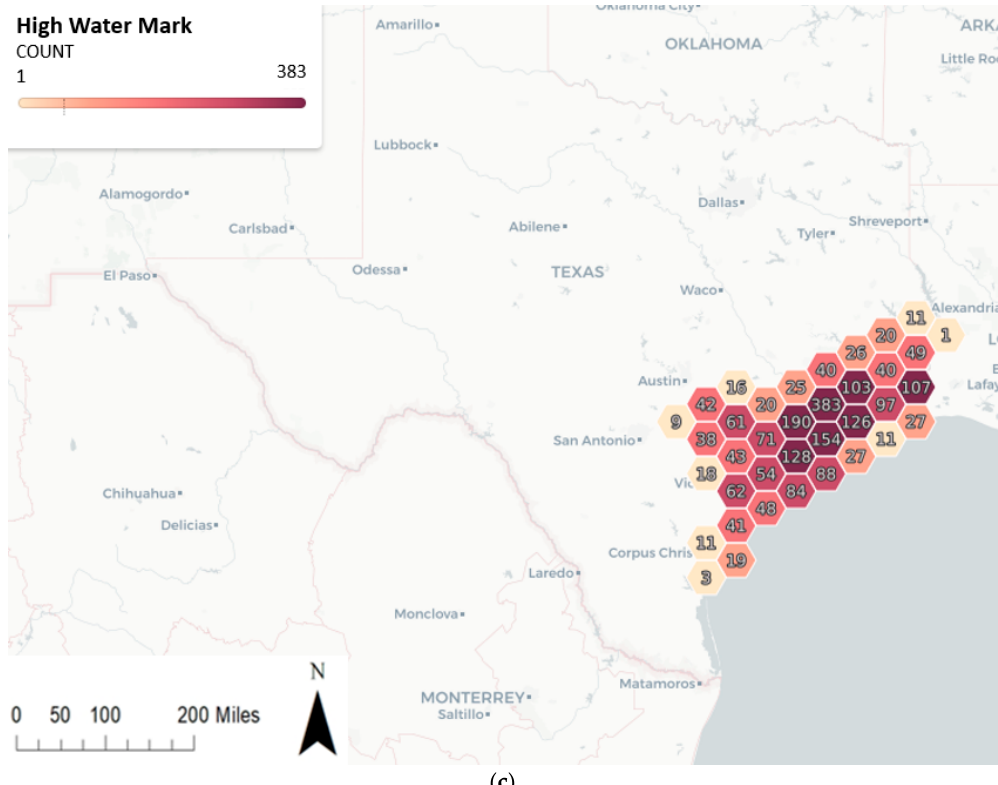
Figure 6. Map examples showing local gazetteer plotted for two themes: ( a ) Shelter (from 2990 tweets); ( b ) Power (from 752 tweets), and ( c ) the high water mark location distribution from USGS. In